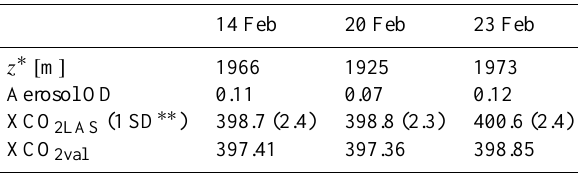
Table 3. Partial column-averaged CO 2 from the ground to air- plane height and aerosol optical depth from the 0.5 to 2km (February